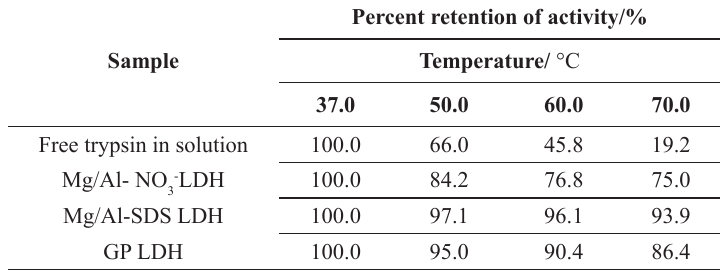
Table 3: Percent retention of activity in immobilized trypsin and trypsin in free solution